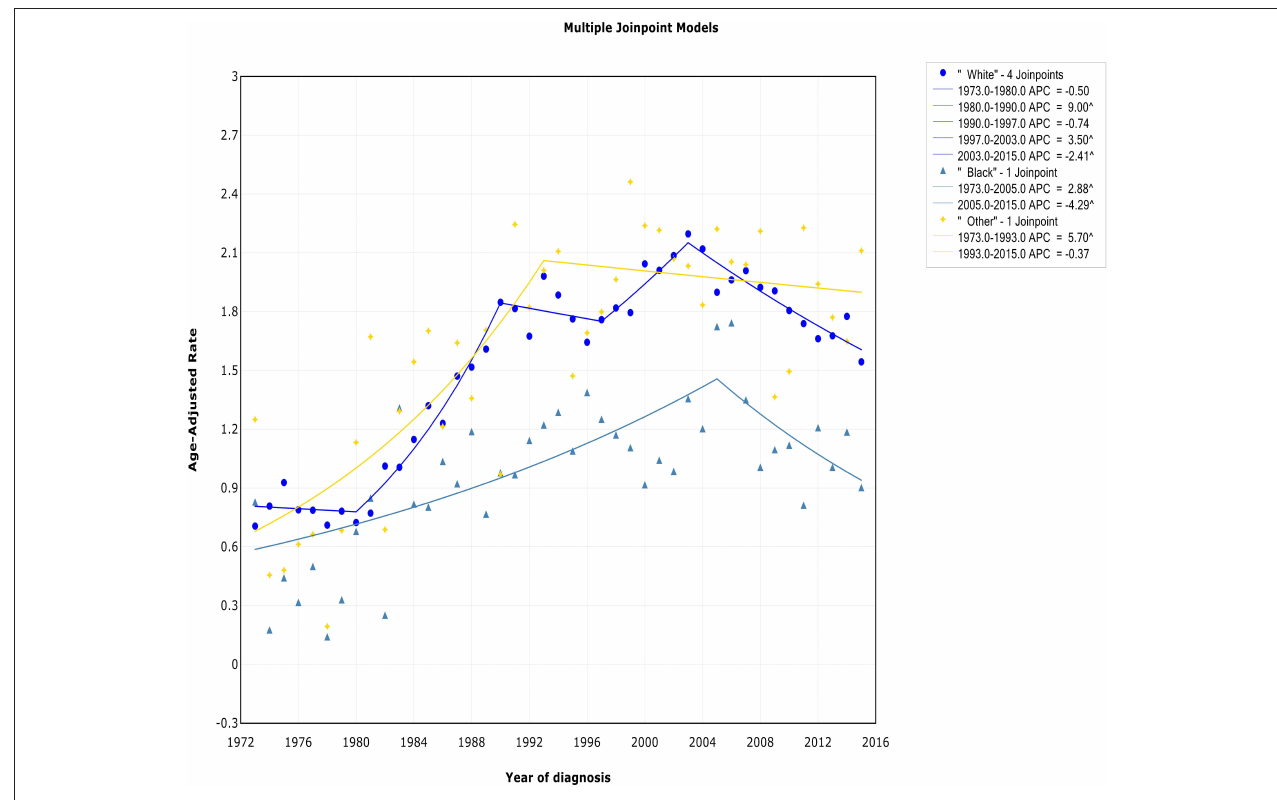
FIGURE 5 | Trends of annual incidence of extranodal DLBCL according to